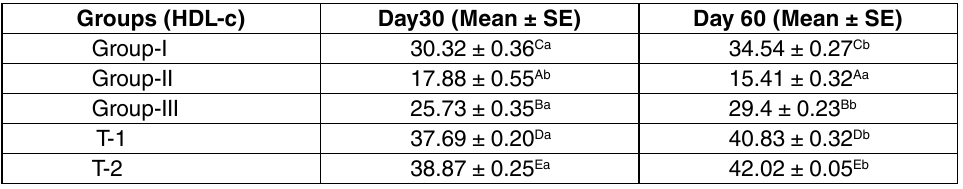
table 9. The mean±SE serum HDL-cholesterol (mg/dl) values in different treatment groups.